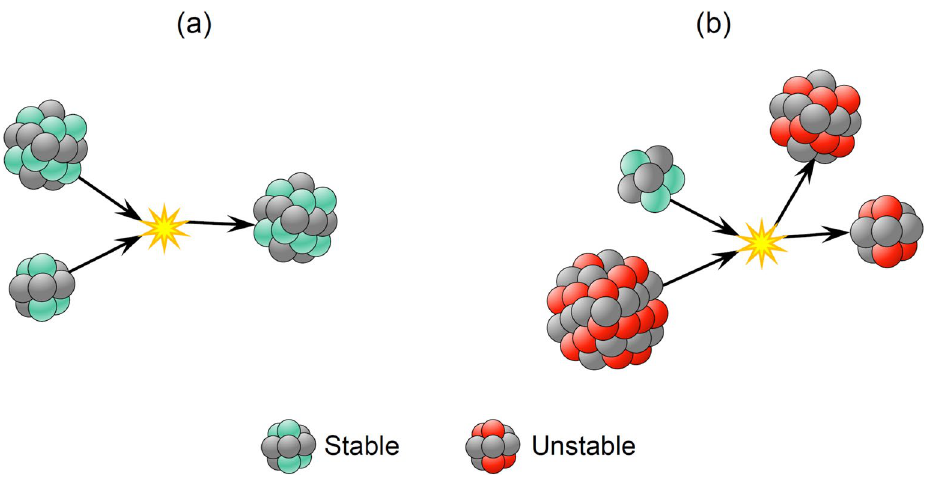
Figure 2. Nuclear reactions: ( a ) fusion, and ( b )